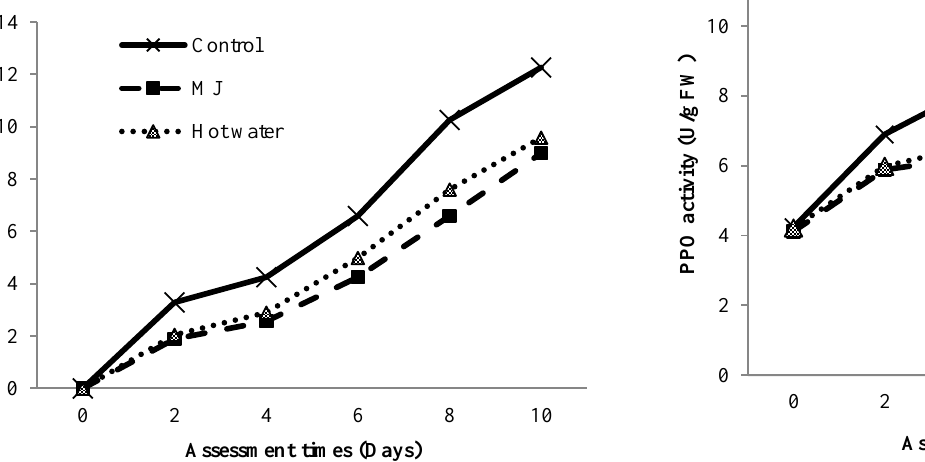
Figure 5. Effects of different postharvest treatments on ployphenol oxidase (PPO) activity of apricot fruits during storage at room temperature (MJ: methyl jasmonic